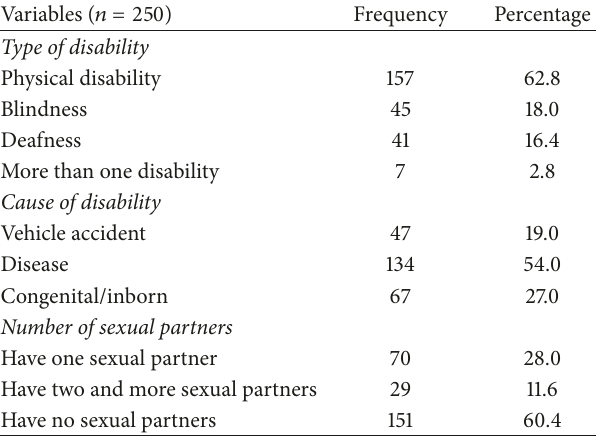
Table1:Sociodemographiccharacteristicsofthestudyrespondents, Table 1: